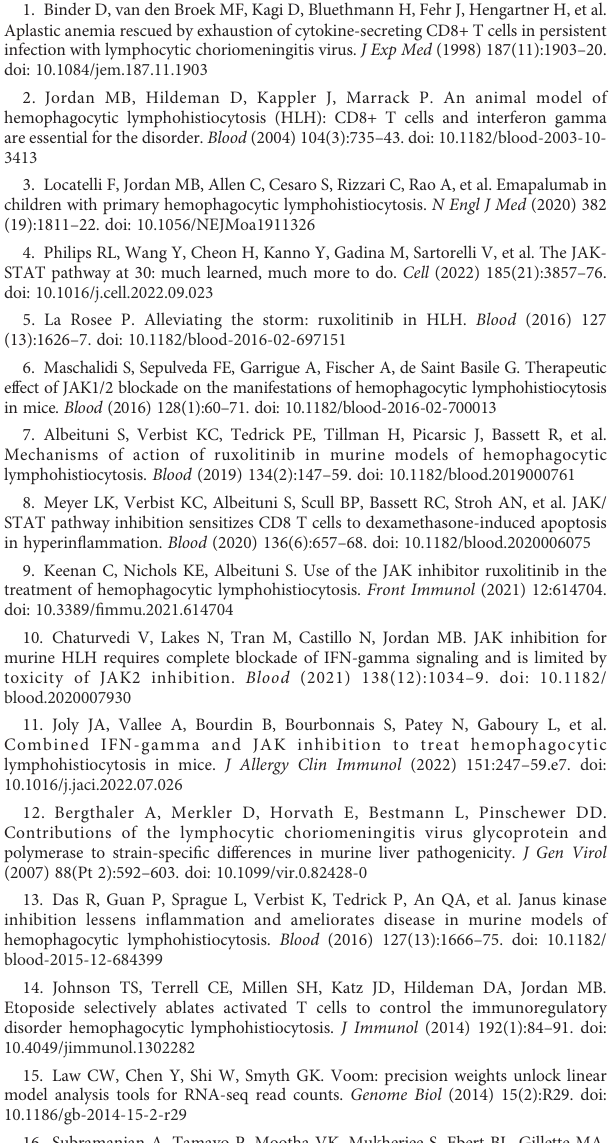
SUPPLEMENTARY FIGURE 5 Leading edge genes in the top pathways identi fi ed by GSEA analysis. Heatmaps demonstrating the top 20 leading edge genes in enriched in hallmark gene sets when comparing ruxolitinib to aIFNg (A, B) , aIFNg to combination treatment (C, D) , and ruxolitinib to combination treatment (E, F)